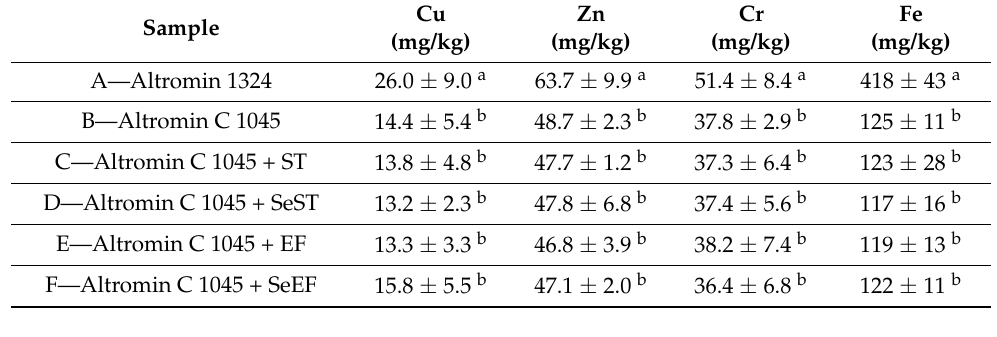
Table 2. Total contents of the elements in the feedstuff (mg/kg wet weight, n = 3). The averages marked by the same letter do not significantly differ at p < 0.05 within the individual columns; data are presented as the mean ± expanded uncertainty with a coverage factor k = 2.